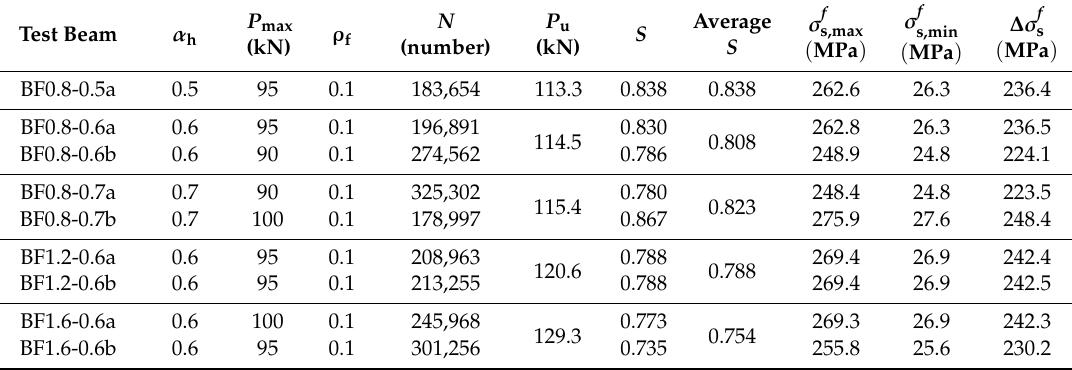
Table 4. Stress level of test beams and stress amplitude of longitudinal tensile